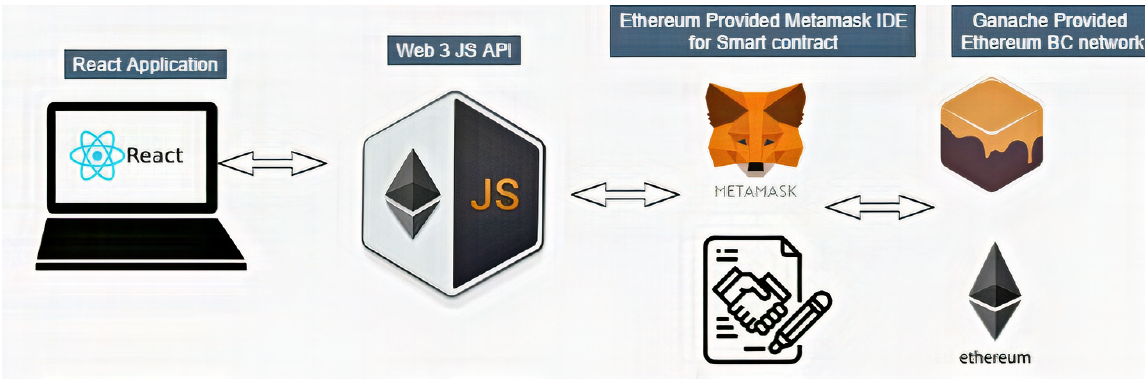
Figure 5. Workplan of the blockchain